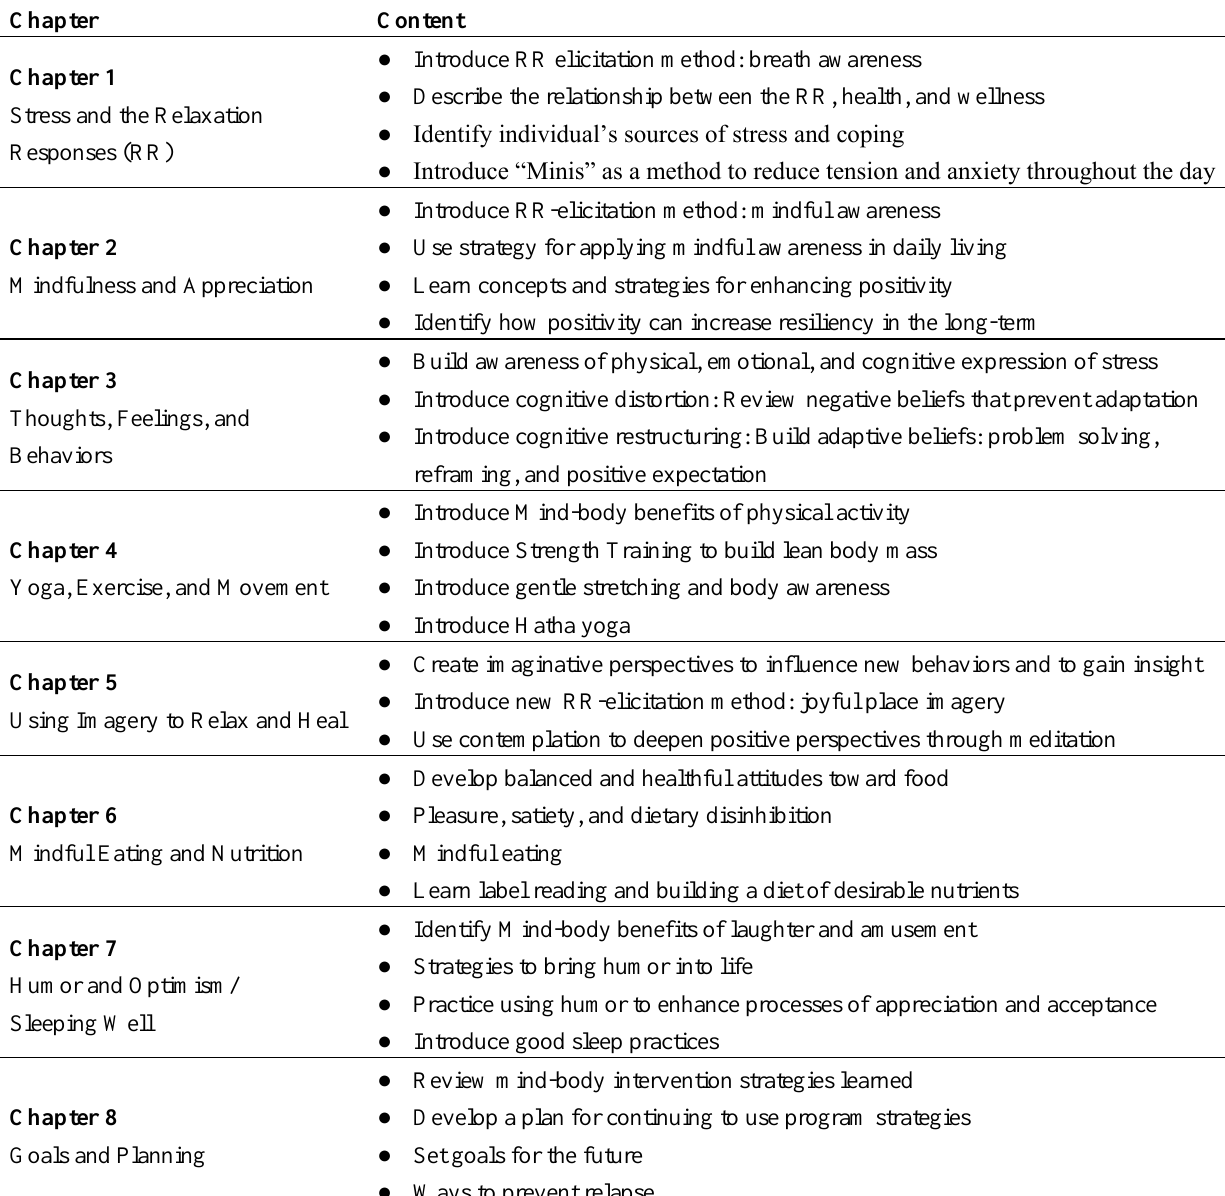
Table 1. RR-based group intervention chapters and